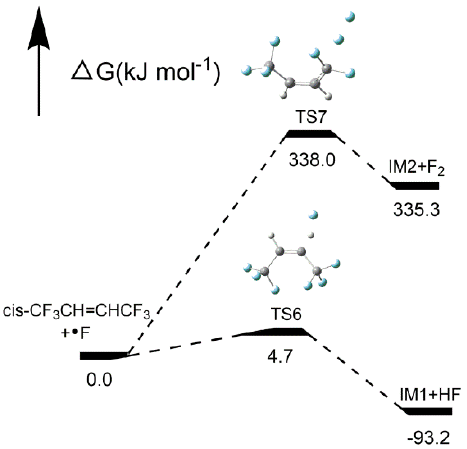
Figure 16. Energy profiles for reaction pathways of cis -CF 3 CH = CHCF 3 + H • . C, H and F atoms are represented with black, gray and blue balls, respectively.